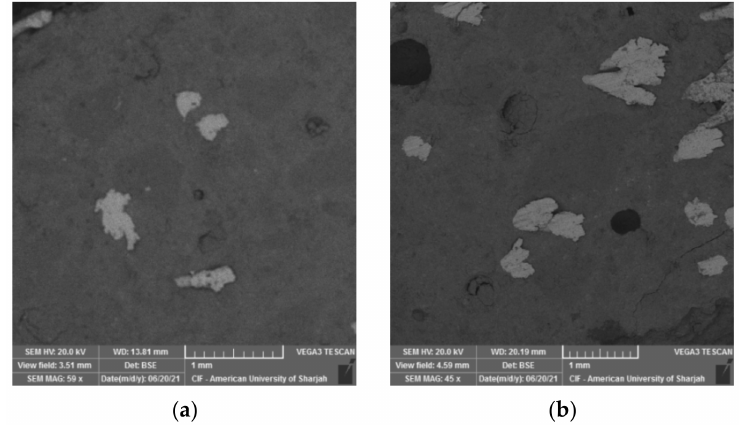
Figure 14. Fiber-matrix bond at late ages of WC. ( a ) GB30 mix; ( b ) GB15FA15